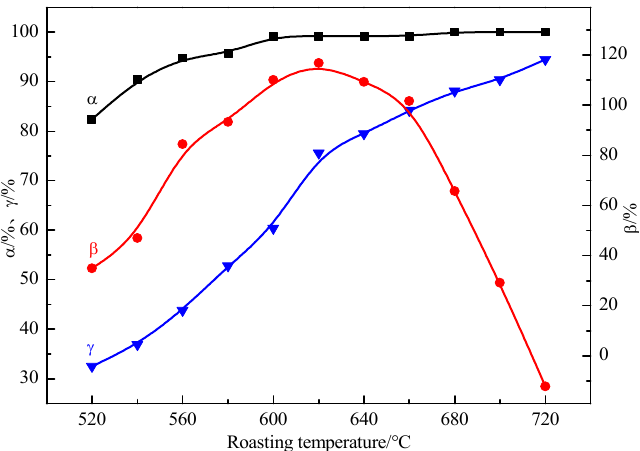
Figure 6. Trend of sulfur mass fraction and the desulfurization of roasted ore at various tempera ‐ tures. α —desulfurization ratio of sulfide sulfur; β —increasing ratio of sulfate sulfur; γ —dehydra ‐ tion